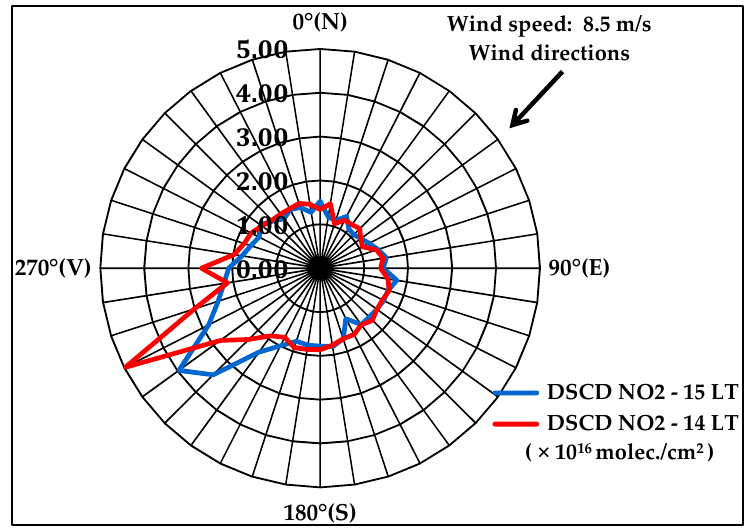
Figure 6. NO 2 di ff erential slant column densities (DSCD) results using full 360 ◦ (HSM) by Figure 6. NO 2 differential slant column densities (DSCD) results using full 360° (HSM) by UGAL- UGAL-2D-DOAS system on 3 June 2D-DOAS system on 3 June 2017.